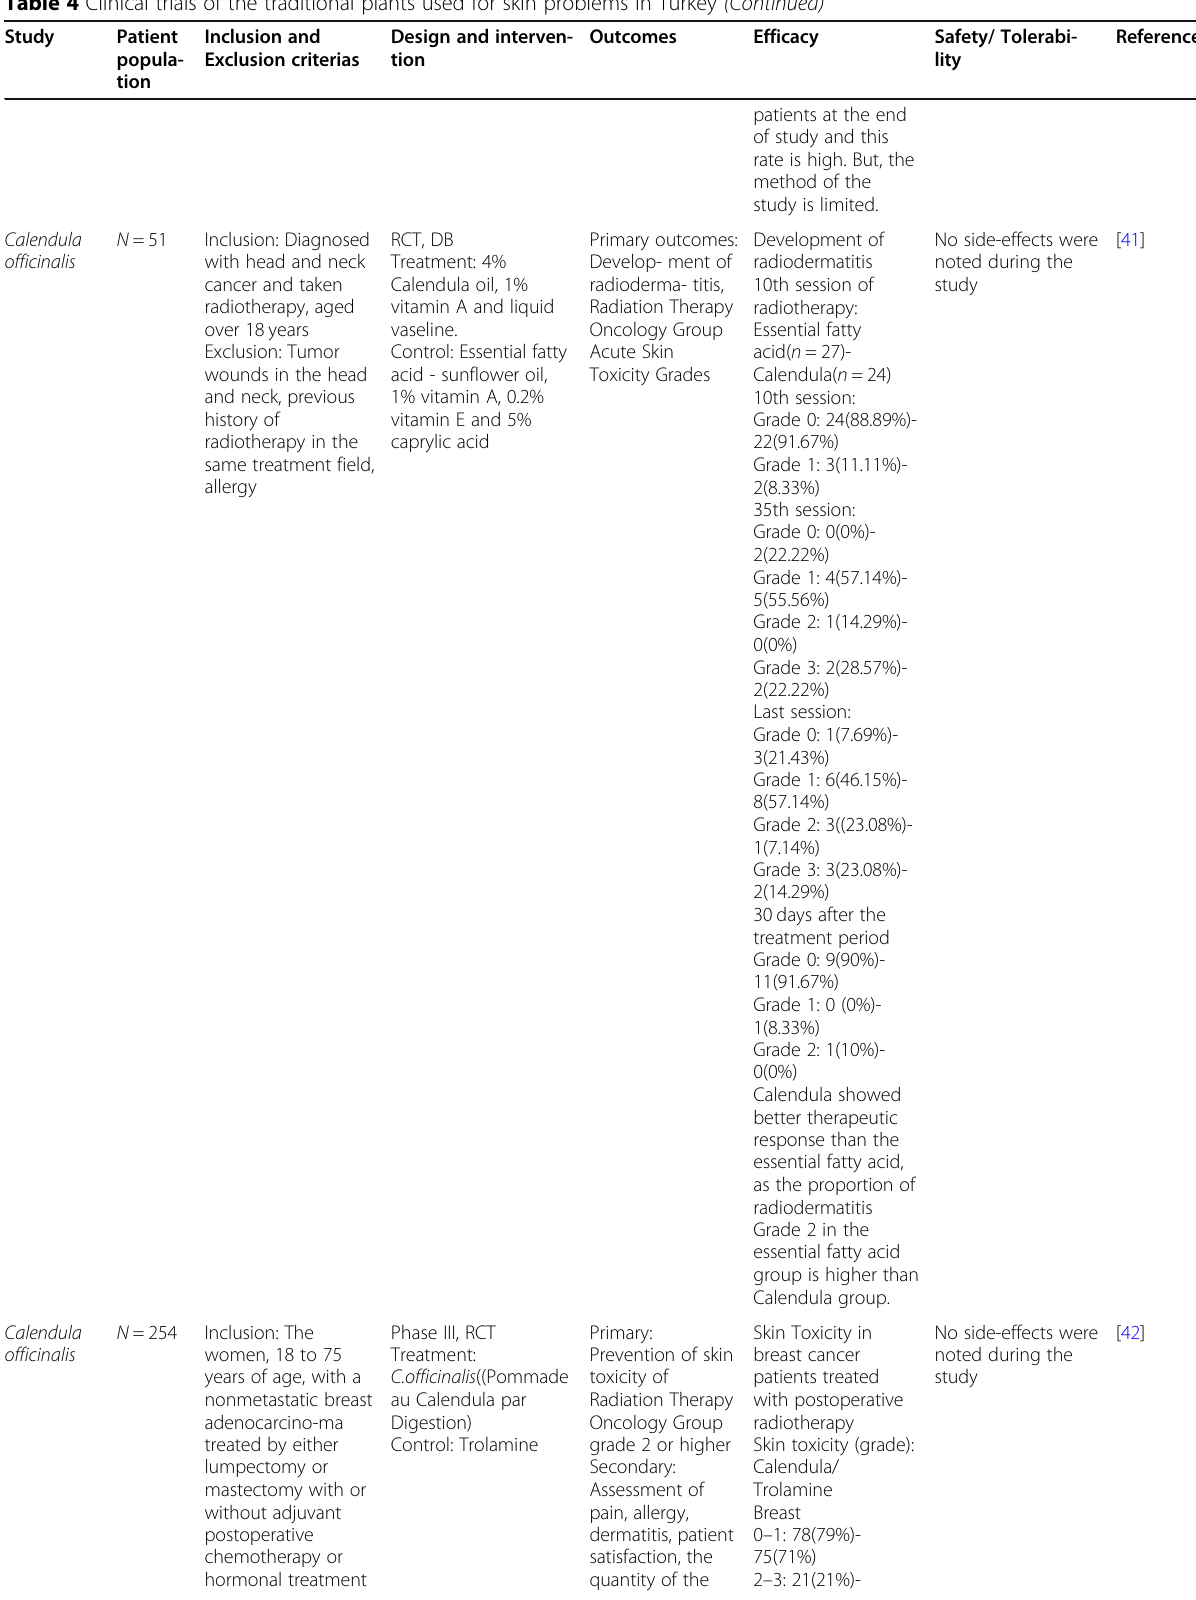
Table 4 Clinical trials of the traditional plants used for skin problems in Turkey (Continued) Study Patient Inclusion and popula- Exclusion criterias